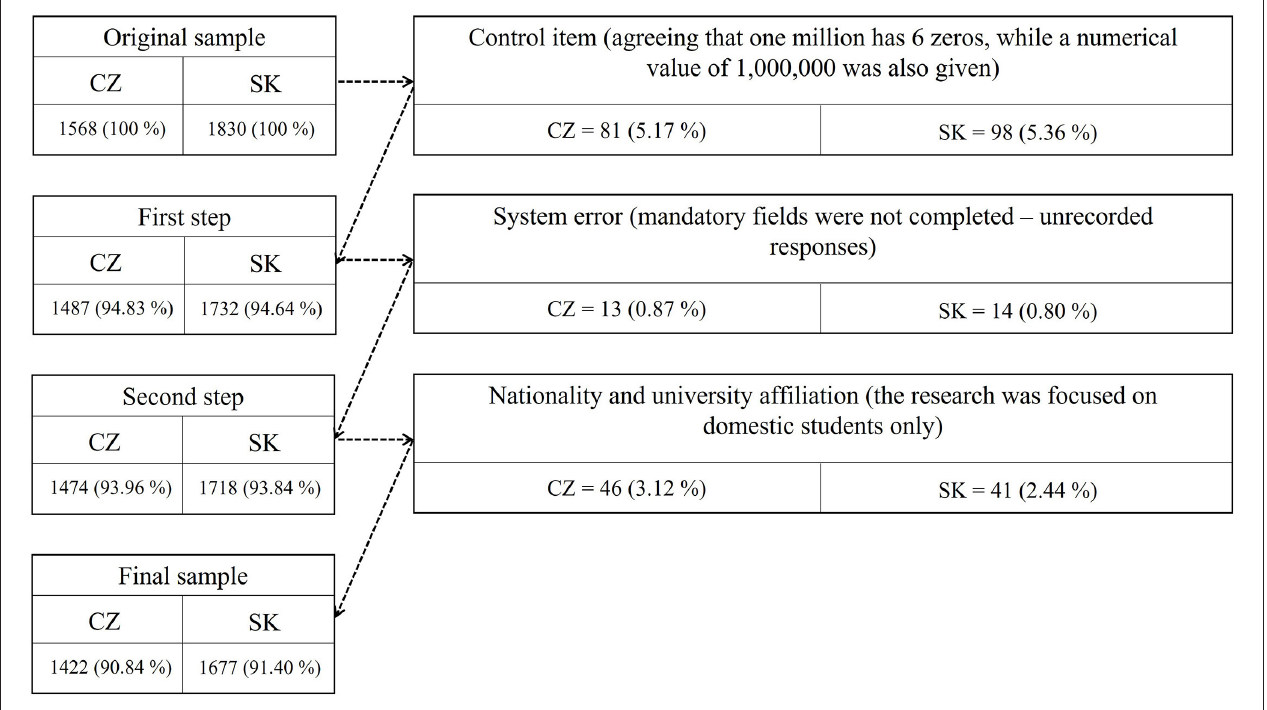
FIGURE 1 | Selection process to obtain the final